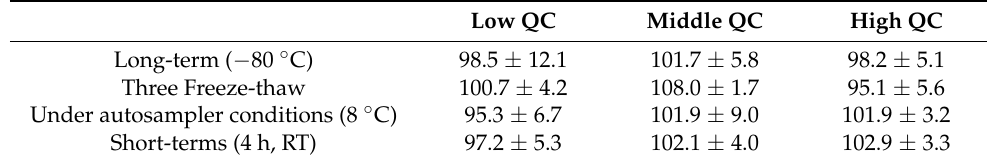
Table 4. Stability of voriconazole under various storage conditions (data are mean ± SD, n = 3).